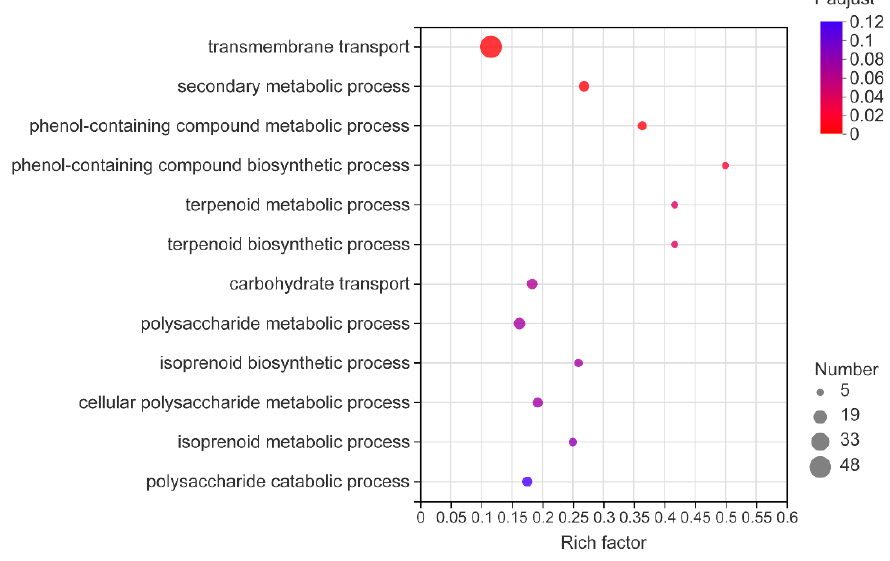
Figure 5. Enriched biological process Gene Ontology (GO) terms in